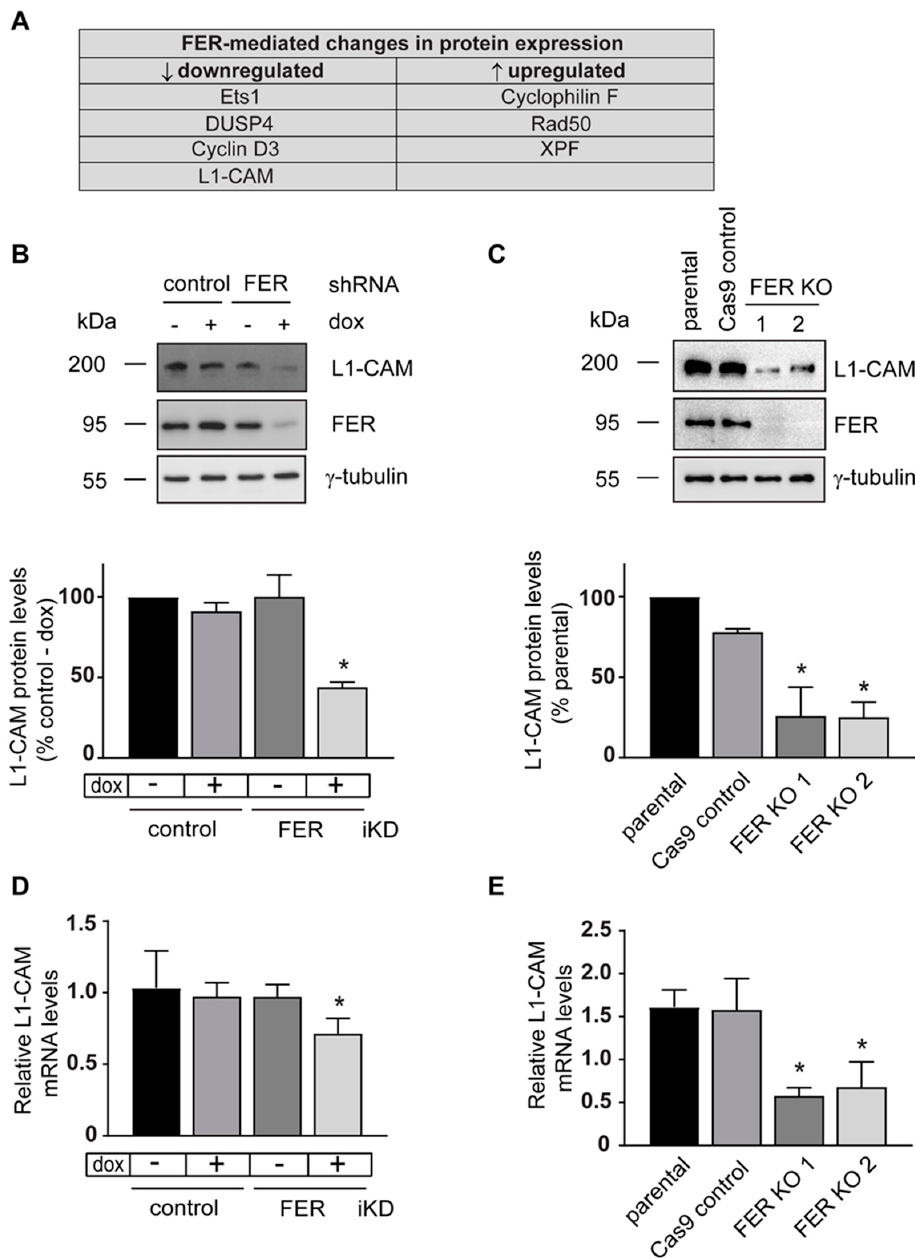
Figure 3. Functional proteomics reveal that L1-CAM is regulated by FER kinase in melanoma cells. ( A ) Control and FER iKD 131/4-5B1 cells were cultured in medium with or without 2 µ g/mL of dox for 120 h. The levels of 306 proteins in control- and FER shRNA-expressing melanoma cell lysates were compared using reverse phase protein array (RPPA) analysis. The table shows proteins that were up- or downregulated in FER-depleted cells relative to control cells. L1-CAM protein levels decrease in FER-depleted melanoma cells. L1-CAM protein levels were analyzed by immunoblot in ( B ) 131/4-5B1 control and FER iKD cells and ( C ) A375-MA2 parental, Cas9 control and FER KO cells. Histograms represent mean L1-CAM protein levels ± SEM ( N = 3) normalized to γ -tubulin and expressed relative to control—dox cells ( B ) or to parental cells ( C ). FER-depletion leads to reduced L1-CAM mRNA levels. L1-CAM mRNA levels were analyzed by real-time quantitative PCR in ( D ) 131/4-5B1 control and FER iKD cells and ( E ) A375-MA2 parental, Cas9 control and FER KO cells. Histograms represent mean L1-CAM mRNA levels ± SEM ( N = 3) normalized to HMBS or HPRT1. * represents p < 0.05 (One-way ANOVA, Tukey’s post hoc test).